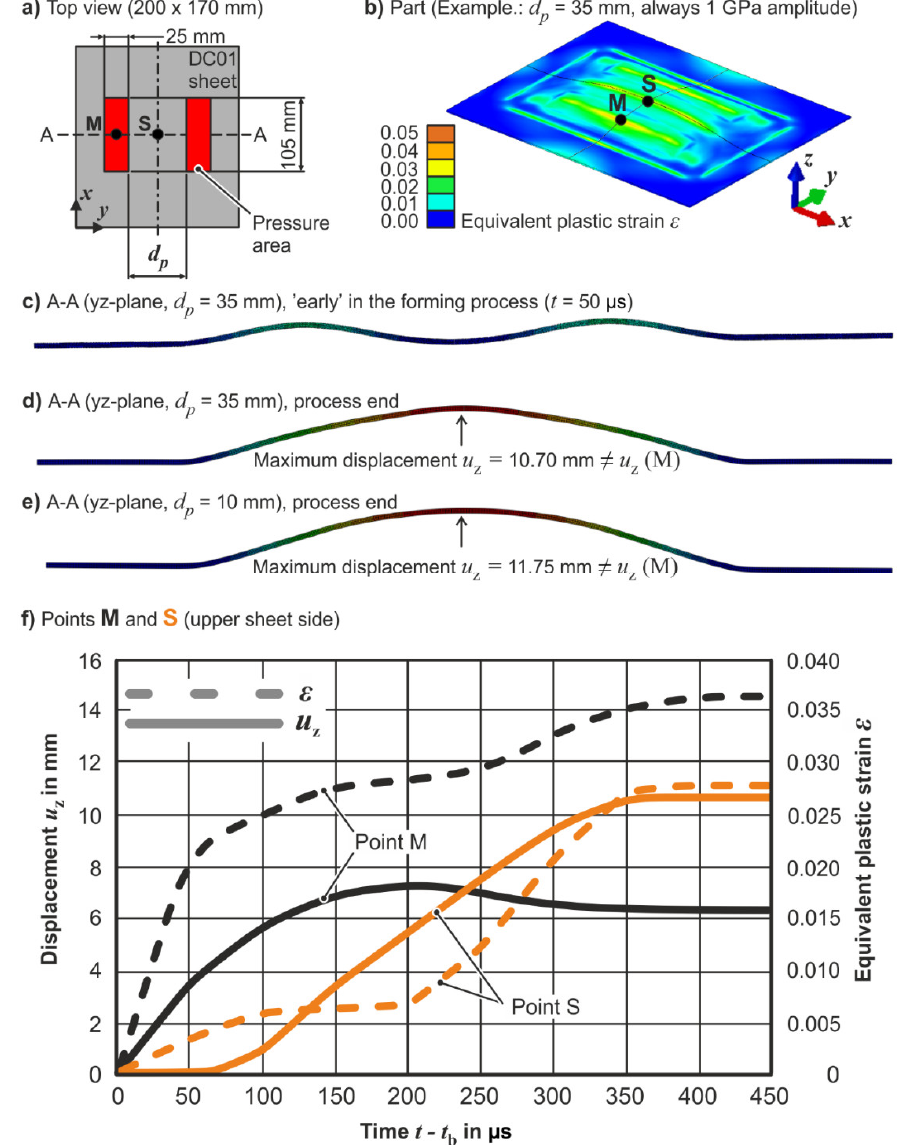
Figure 6. Numerical results for pressure distribution PD3: ( a ) sketch, ( b ) formed part, ( c – e ) selected sectional views, ( f ) selected node-/integration point treatment.